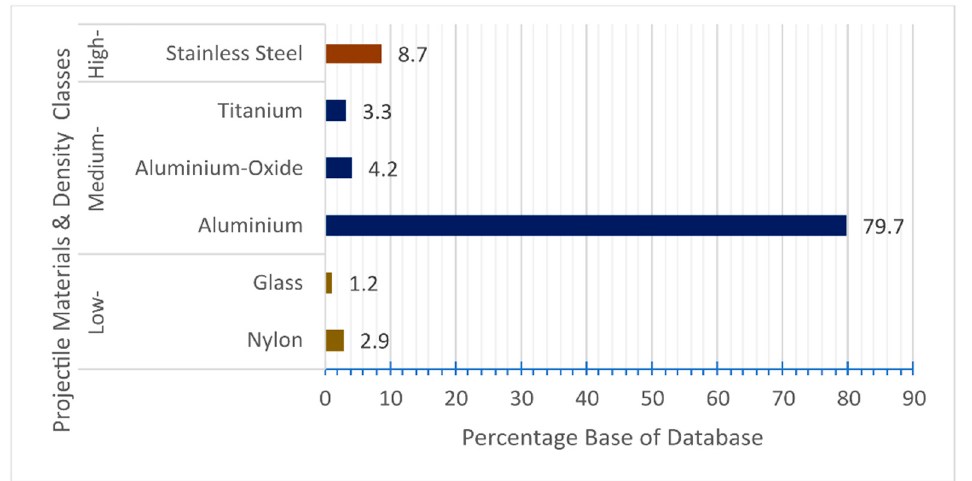
Figure 9. HCSP projectile material breakdown by percentage.